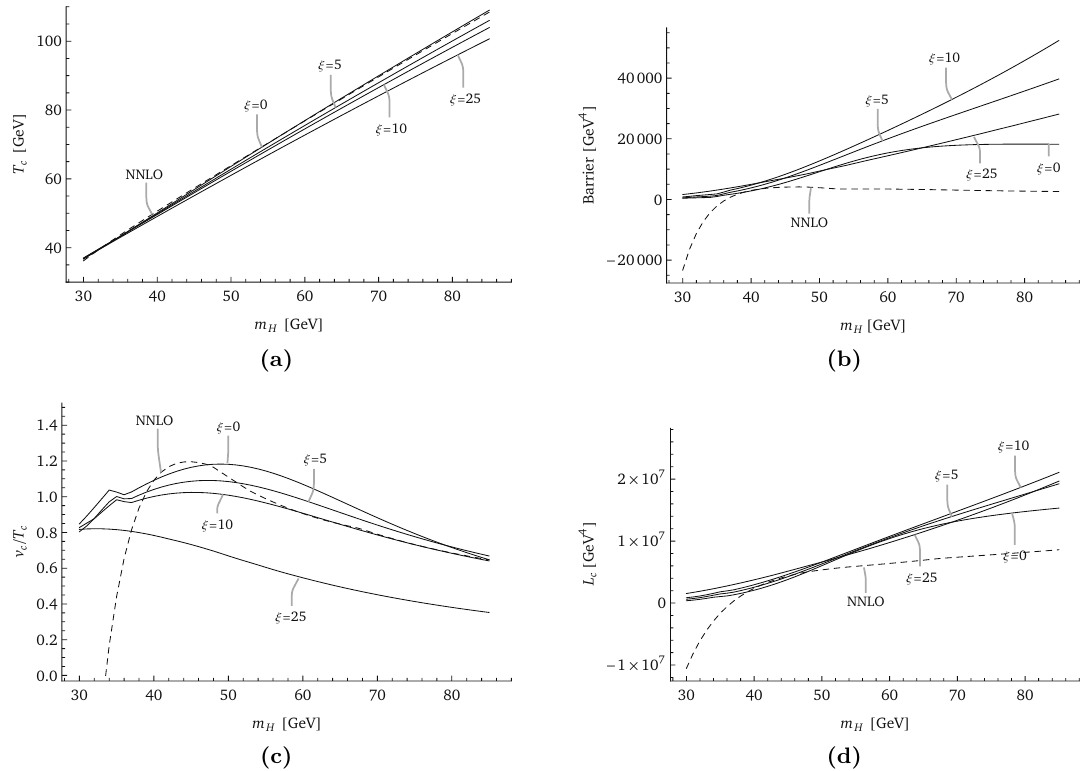
Figure 3 . Traditional method compared to the gauge-invariant method for different Higgs masses. With (a) the critical temperature, (b) the barrier height, (c) the phase transition strength, and (d) the latent